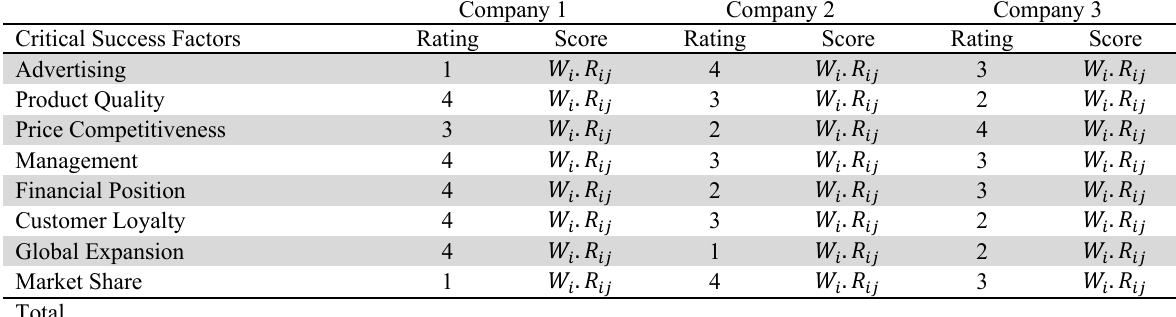
trix is provi ided in Tabl Matrix with Fuzzy Wei Compan ny Rating